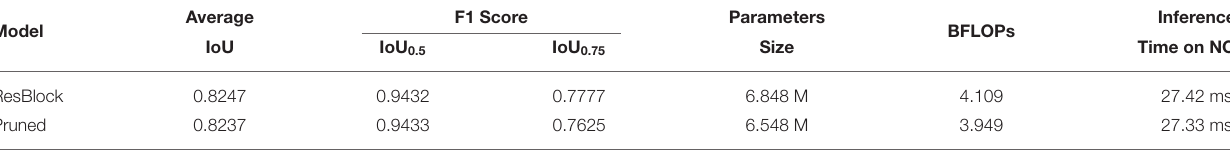
TABLE 4 | Performance data by pruning.